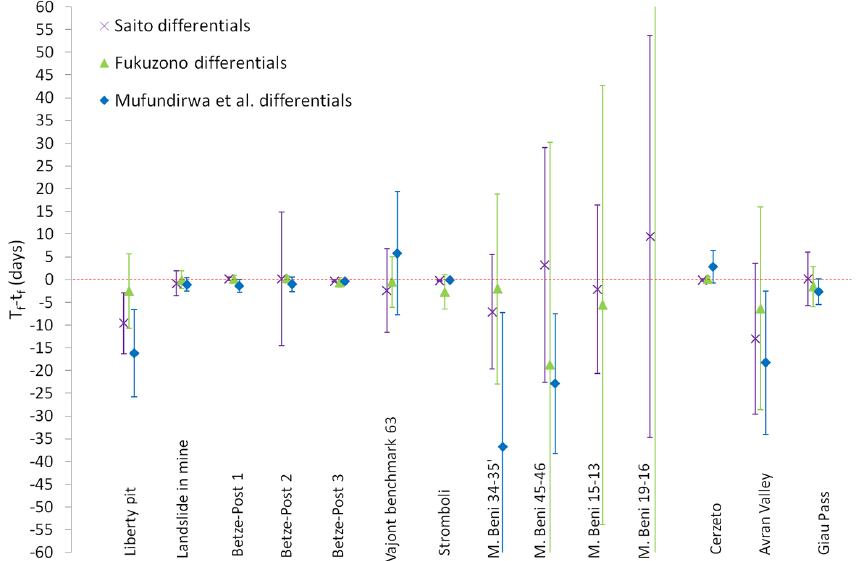
Figure 3. This graph represents for each method the differential between the mean of the forecasts ( t f ) and the actual time of failure ( T f ). Negative values are safe predictions for anticipating the time of failure. The dashed line represents exact predictions ( T f − t f = 0). The standard deviations of the forecasts are represented as error bars. For the Betze-Post and Mount Beni landslides time series from different measuring points are reported. The rock mass failure, Asamushi landslide and the artificial landslides are not shown because they were monitored in a different timescale (hours or